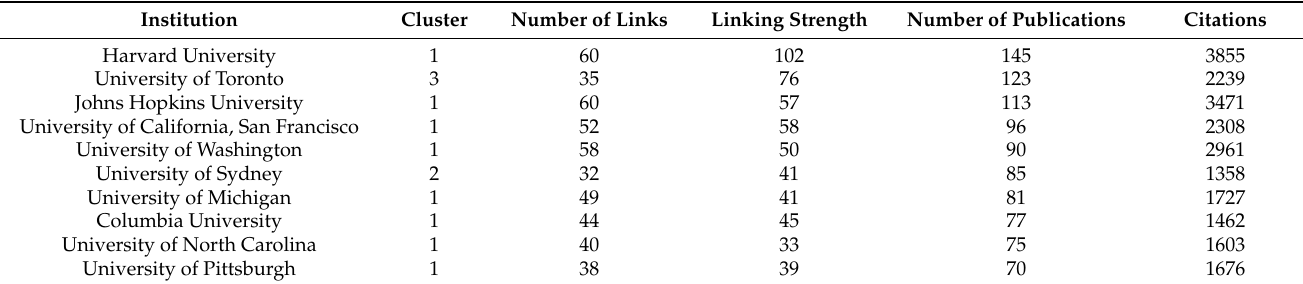
Table 4. Top 10 research institutions of health technology research.